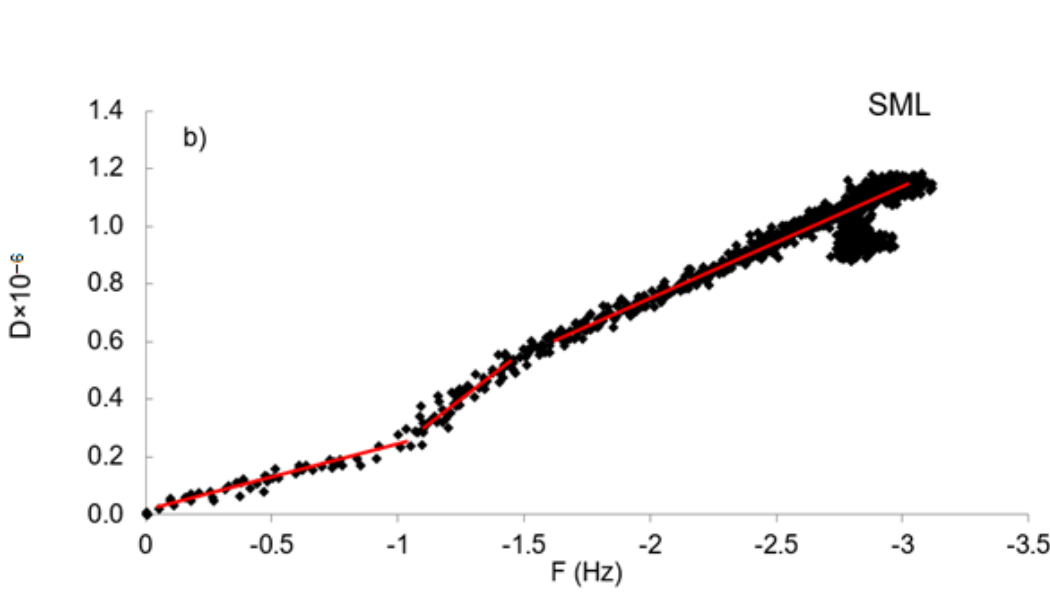
Figure 8. Dissipation change of the sensors as a function of frequency change for ( a ) SBL ( b ) SML for 500 mg/L concentration.